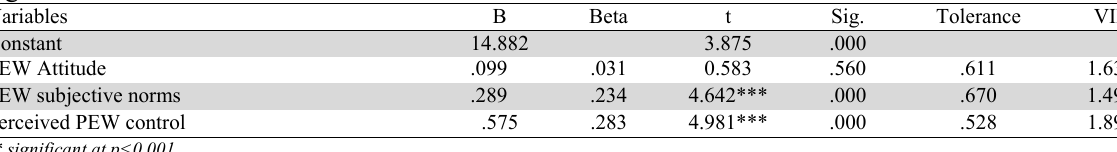
Regression for PEW behavior Variables